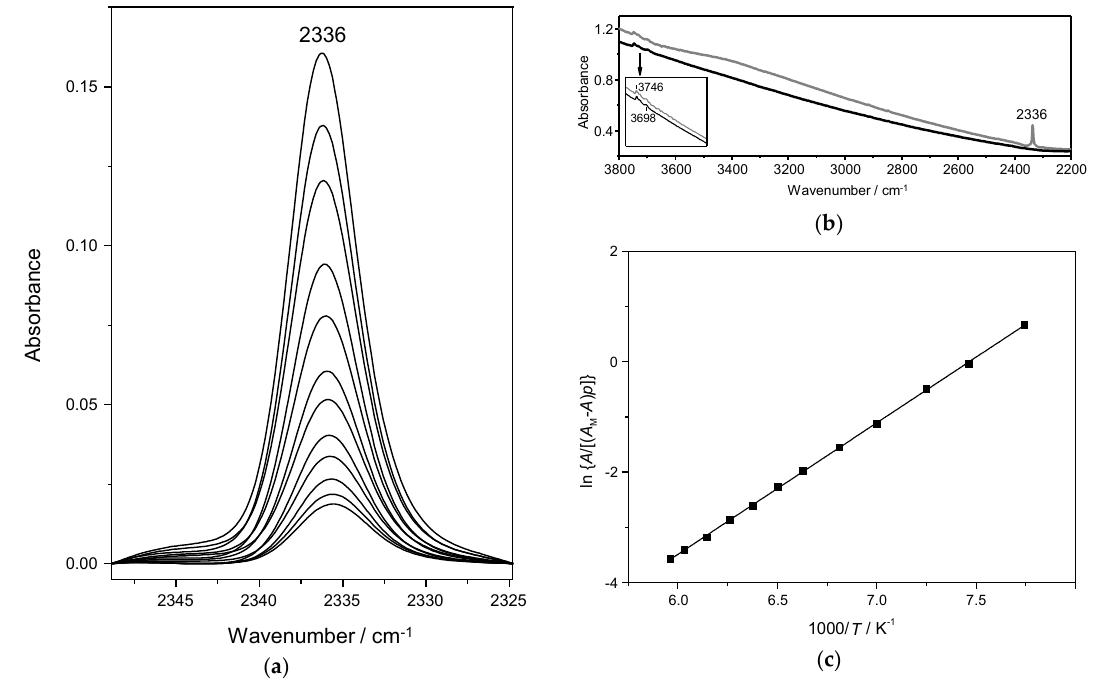
Figure 2. ( a ) Variable-temperature IR spectra (in the N–N stretching region) of N 2 adsorbed in Na-Y. From top to bottom temperature increases from 129 to 177 K; and equilibrium pressure from 2.34 to 5.67 mbar. ( b ) Blank spectrum of the zeolite sample in the 2200 to 3800 cm − 1 (black line) and after dosing with N 2 (grey line). The inset shows a magnification of the O–H stretching region. ( c ) van’t Hoff plot for N 2 adsorbed in Na-Y, data obtained from the IR absorption band at 2336 cm − 1 .